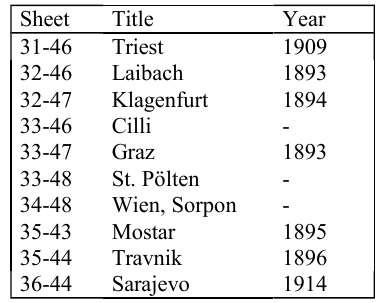
Table 2. List of the georeferenced Austro-Hungarian maps used